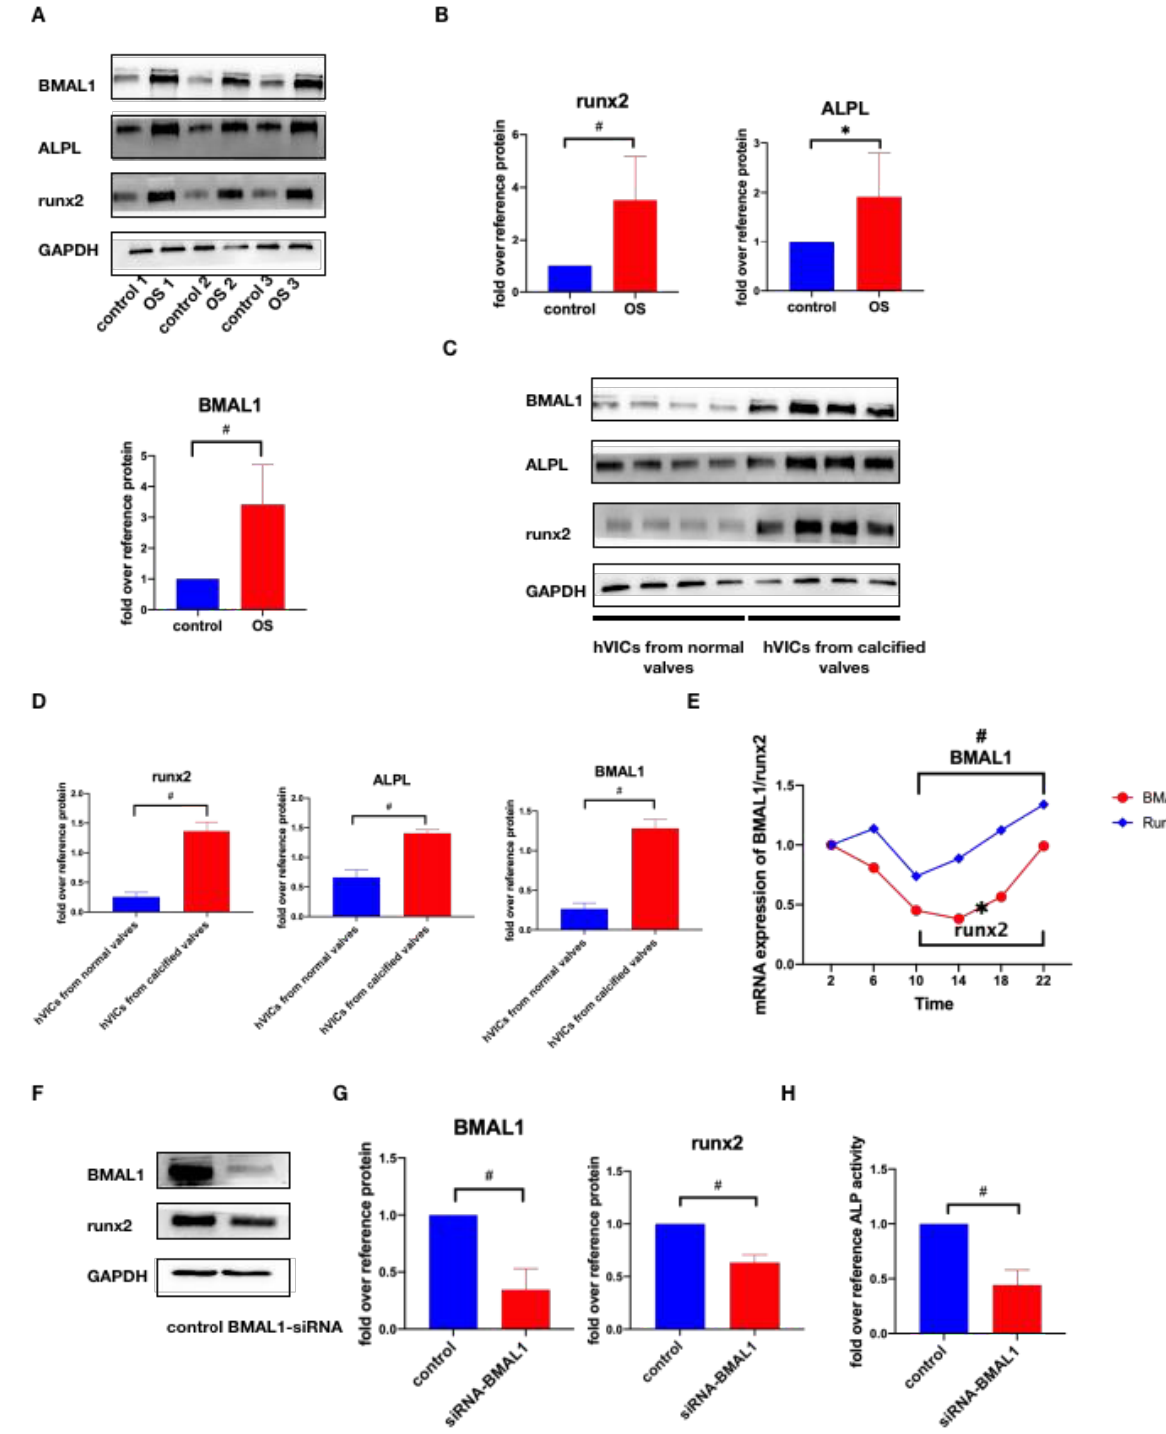
Figure 3. BMAL1 is associated with osteogenic differentiation of HVICs. ( A , B ) osteogenic medium could promote BMAL1, runx2 and ALPL expression in HVICs, with n = 6 for each group. ( C , D ) BMAL1 expression was increased in HVICs isolated from calcified valves compared with HVICs isolated from normal valves, with n = 4 for each group. ( E ) runx2 expression showed circadian rhythms synchronizing with BMAL1 expression, with n = 4 for each group. ( F , G ) after silencing BMAL1, runx2 expression was also reduced, with n = 3 for each group. ( H ) after silencing BMAL1, ALP activity was also reduced, with n = 6 for each group. * p < 0.05, # p < 0.01, OS, osteogenic